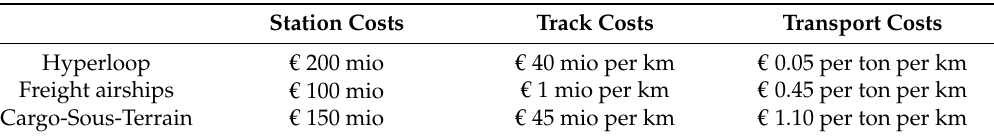
Table 1. Costs for high-performance transport technologies.